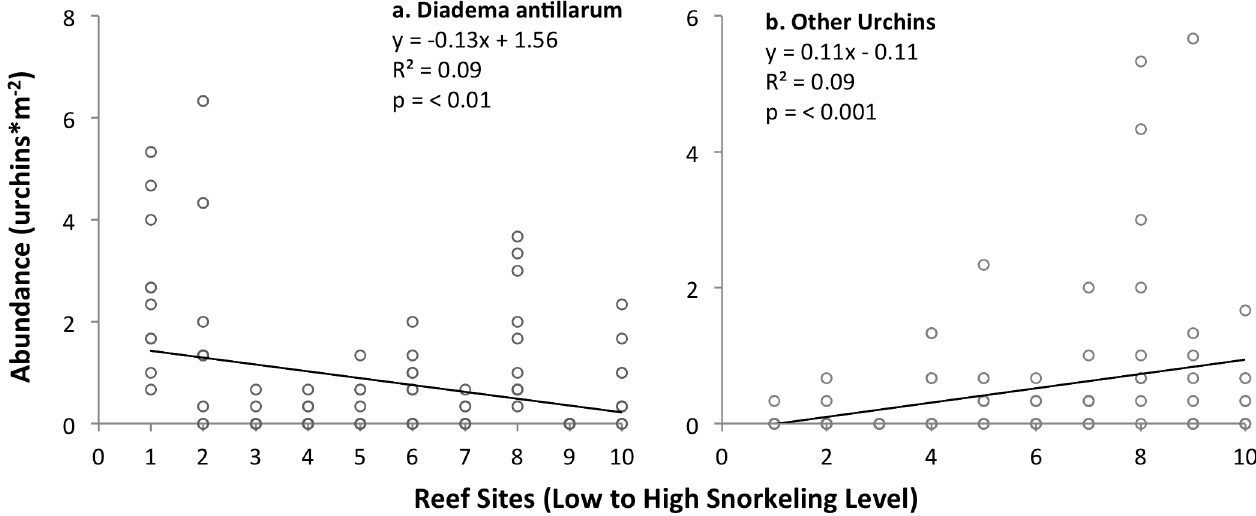
Fig 7. Variation in the abundance of Diadema antillarum and other sea urchin species grouped ( Arbacia punctulata and Eucidaris tribuloides ) among patch reefs ranked by level of snorkeling in Akumal Bay, Mexico. N = 10 transects examinedper reef.